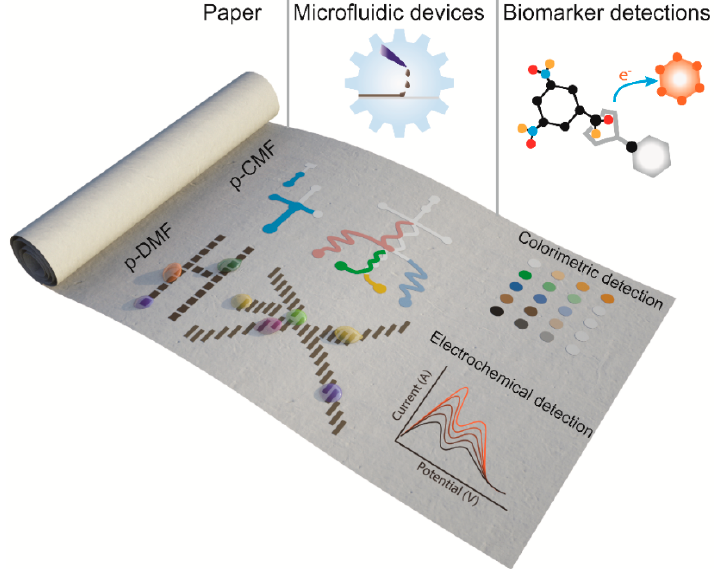
Figure 1. Schematic illustration of a programmable microfluidic device (paper-based continuous-flow microfluidic (p-CMF) and paper-based digital microfluidic (p-DMF)) fabricated on a sheet of paper.